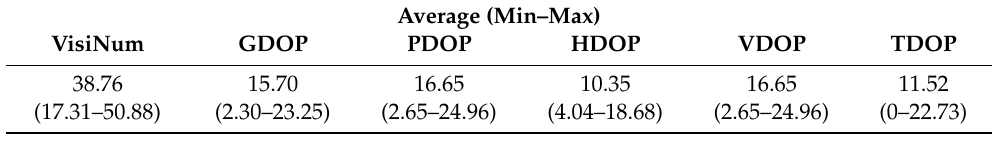
Table 7. Improvement rates (%) of introducing HEO satellites relative to BDS-3 at 30 ◦ N–90 ◦ N region.